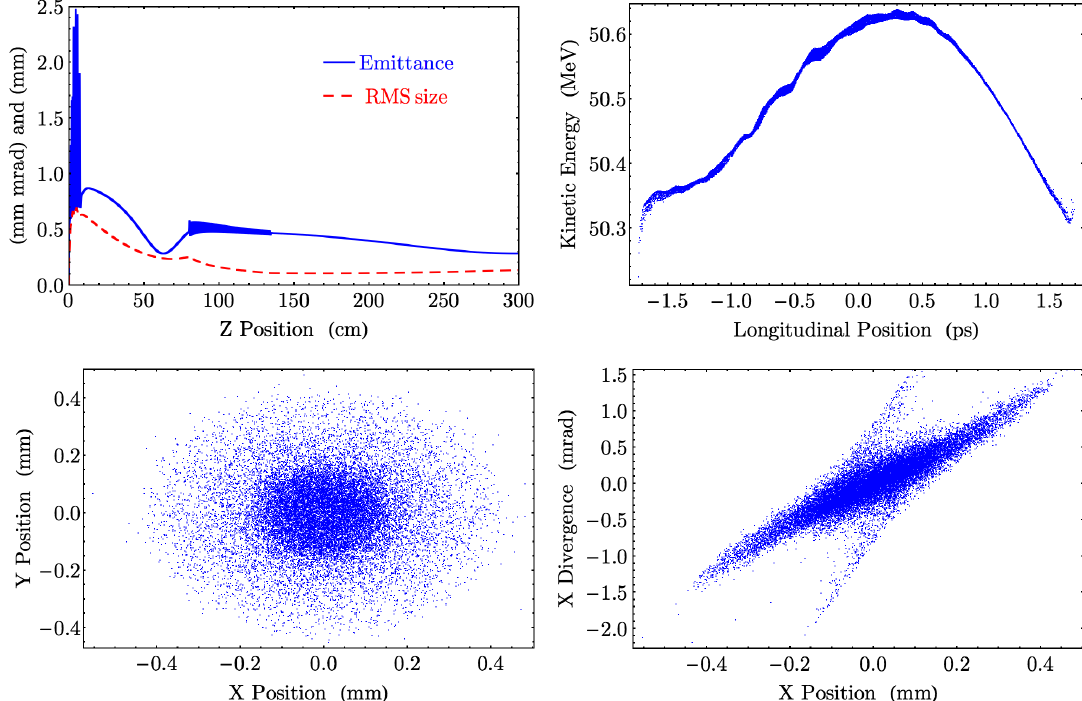
FIG. 7. PARMELA simulation X position (mm) results for the Mark 1 X -band rf gun and a single T53 accelerator section: normalized transverse emittance and beam size; kinetic energy gain through the length of the rf gun; kinetic energy as a function of longitudinal position within the bunch; x phase space of